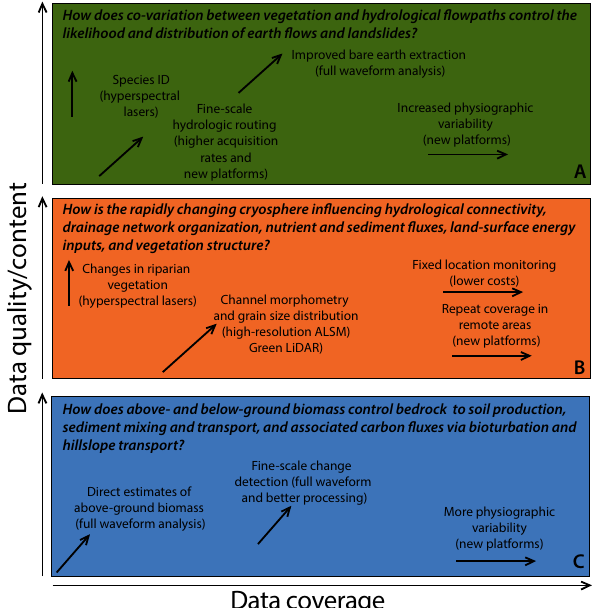
Figure 3. Example CZ research questions conceptualizing the trans- disciplinary potential of lidar data sets when coupled with future technological advances. The questions encompass processes from geomorphology (a) , hydrology (b) , and ecology (c) that overlap spatial and temporal scales. These scales are noted in Fig. 1. The text in the panel notes specific improvements offered and the tech- nology needed in parentheses. The arrows qualitatively represent whether the technological advance expands data coverage and/or data